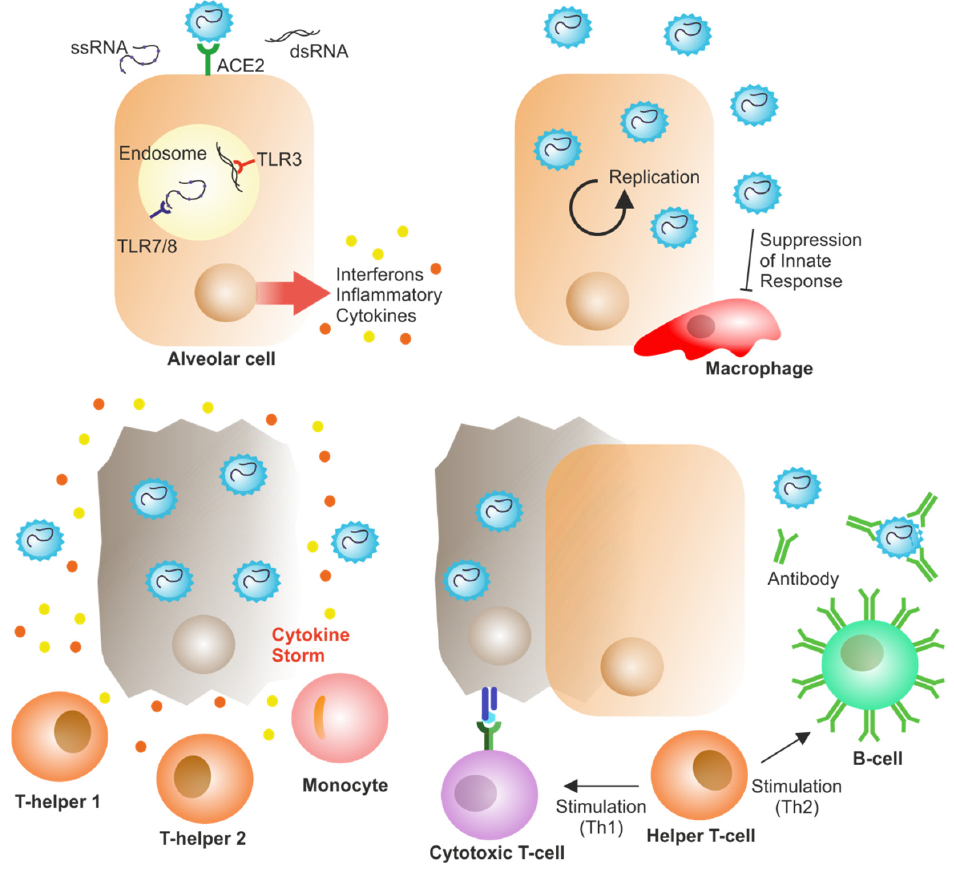
Figure 1. Simplified scheme of the immune response in COVID-19. Note: Infection with SARS-CoV-2 virus by airborne droplets is followed by infection of cells expressing the angiotensin-converting enzyme-2 receptor in the lungs, such as type 2 alveolar cells. The virus suppresses the production of interferons, thus evading innate immunity and then unlimited replication of the virus occurs. Infiltration of monocytes, macrophages, neutrophils, and some other cells leads to an increase in the production of proinflammatory cytokines. In a subset of T-helper cells, stimulation of TH1/TH17 by viral epitopes can lead to increased inflammatory responses. This inflammatory response leads to a “cytokine storm” and consequently to immunopathologies, such as pulmonary edema and pneumonia. Cytotoxic T cells attracted to the site of infection attempt to lyse virus-infected cells in the lungs. B cells also recognize viral proteins and are activated to produce antibodies specific to